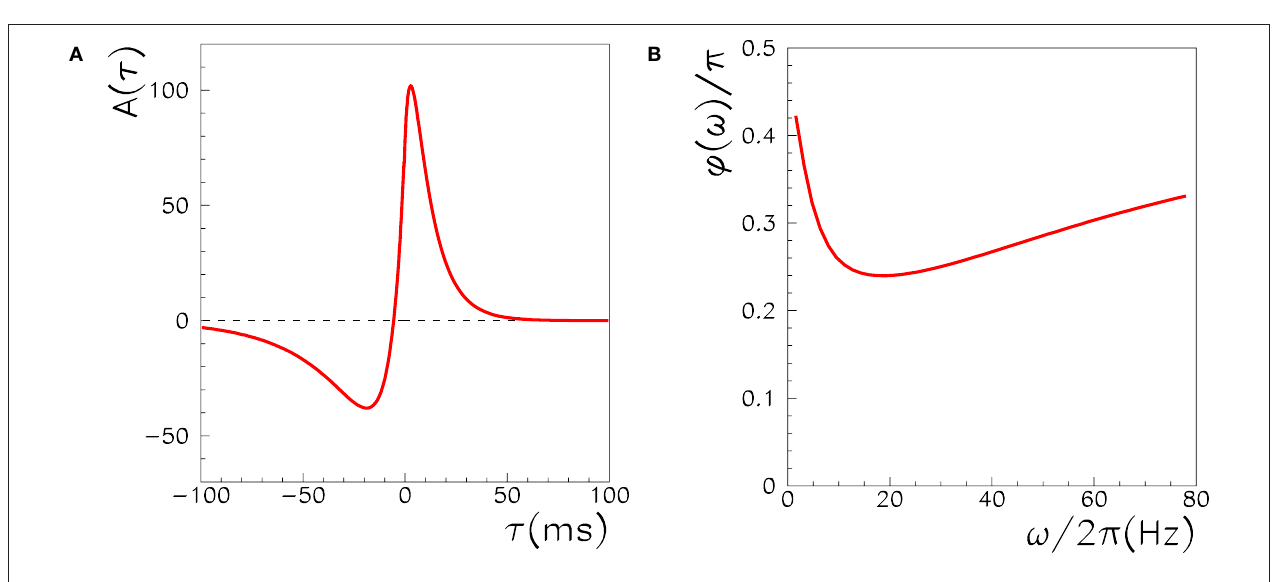
Figure 1 | (A) The learning window A ( τ ) used in the learning rule in Eq . (1) to model STDP. The window is the one introduced and motivated by Abarbanel et al. (2002), A if τ < 0, with the same parameters used in Abarbanel et al. (2002) to fit the experimental data